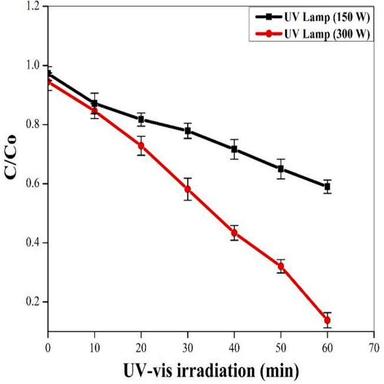
Effect of light intensity under UV–vis irradiation.